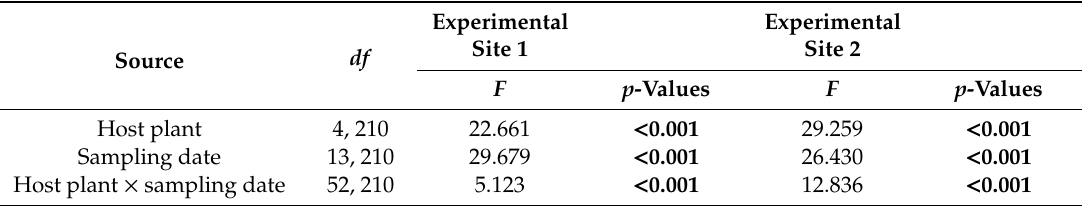
Table 3. Repeated measures MANOVA parameters for effects of host plants, sampling date, and interactions on population dynamics of A. lucorum on host plants .